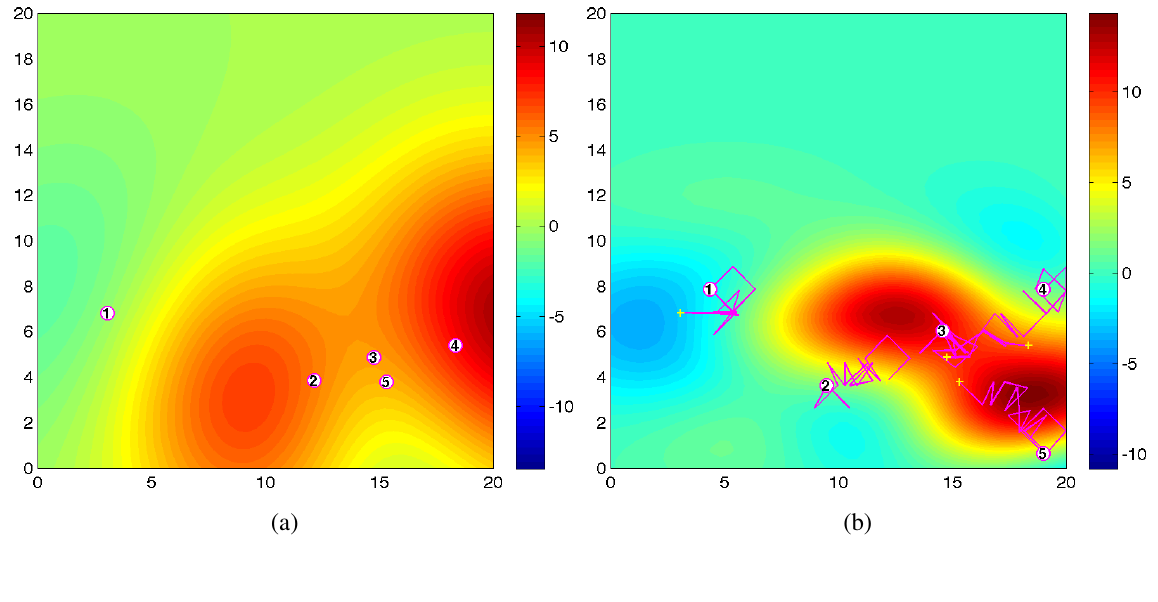
Figure 3. The predicted fields along with agents’ trajectories at (a) t = 1 and (b) t = 20